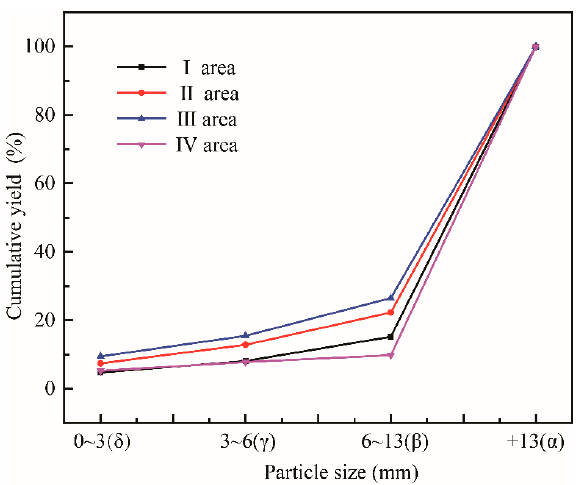
Figure 6. Particle size distribution curve of fragments in different areas of specimen 11.